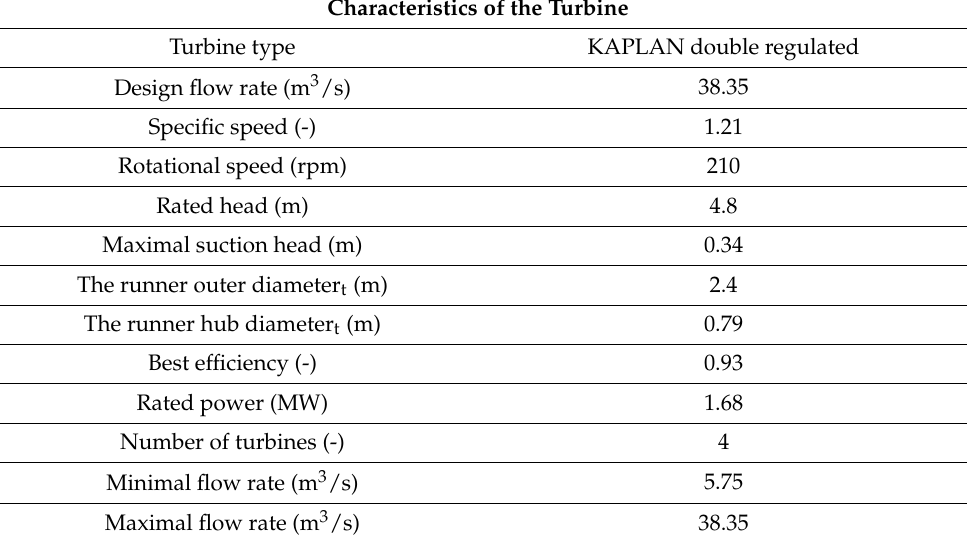
Table 10. Characteristics of the turbine selected.